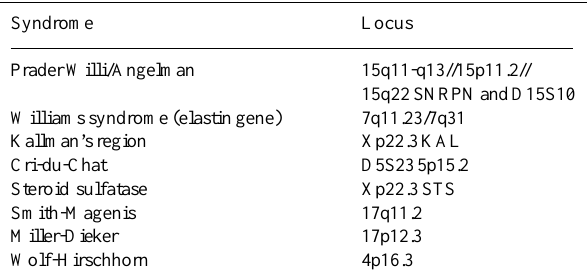
Table III - Microdeletion syndromes. Syndrome